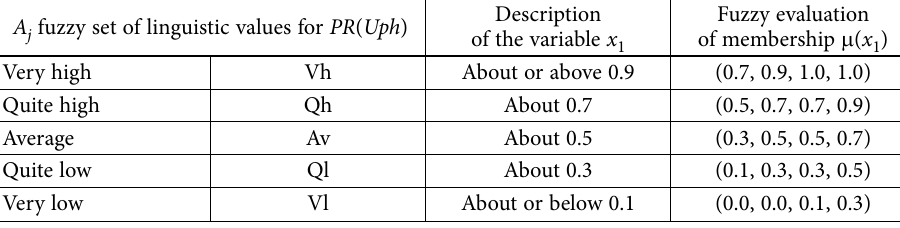
Table 2. Fuzzy interpretation of the linguistic input variable x 1 – PR(Uph) A j fuzzy set of linguistic values for PR ( Uph )